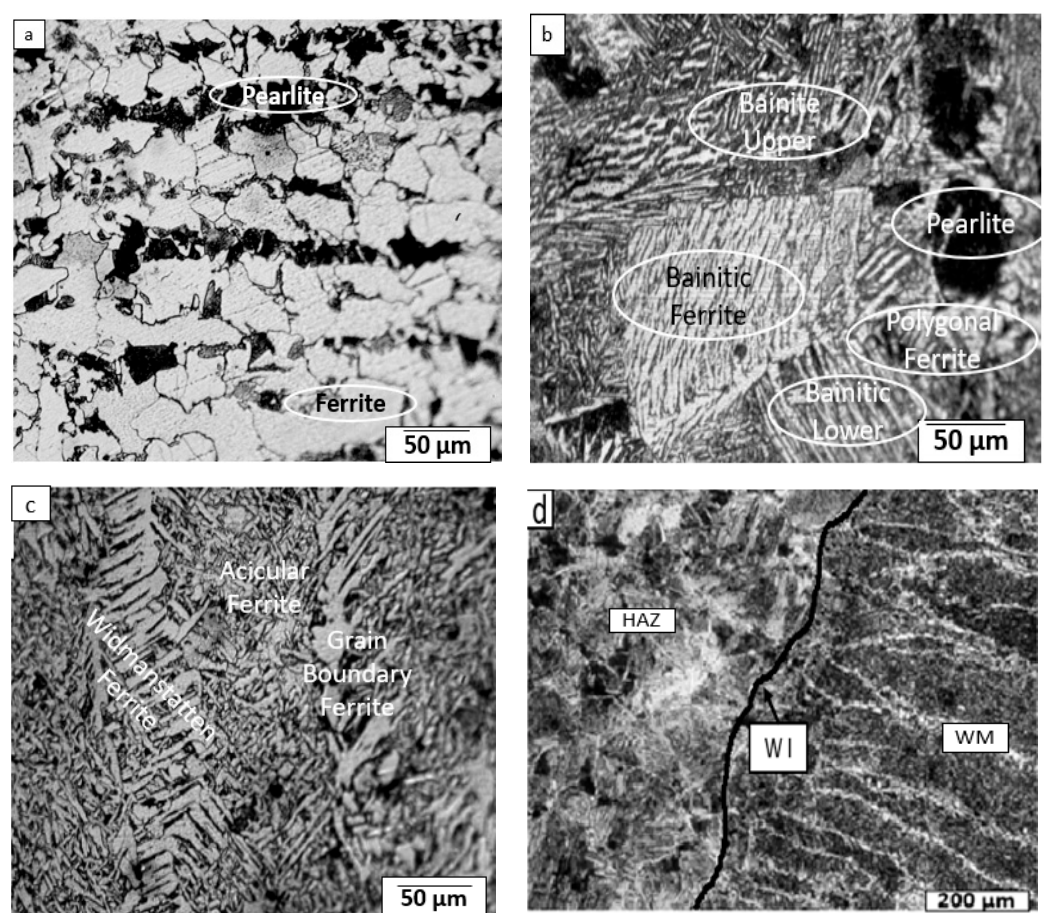
Figure 9. SA 516 Grade 70 Microstructure of ( a ) BM; ( b ) WM; ( c ) HAZ; ( d ) WM/HAZ interface.